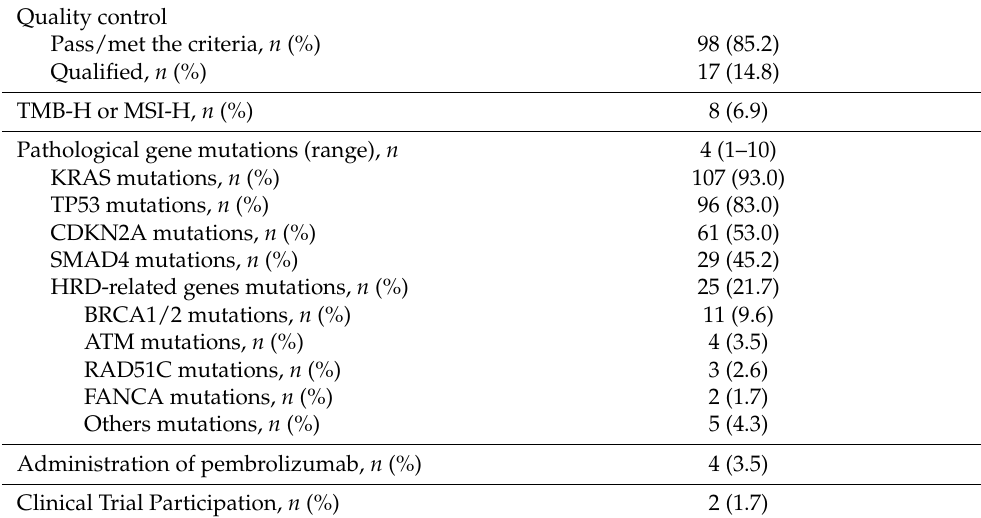
Table 2. The results of comprehensive genomic profiling (CGP) tests.